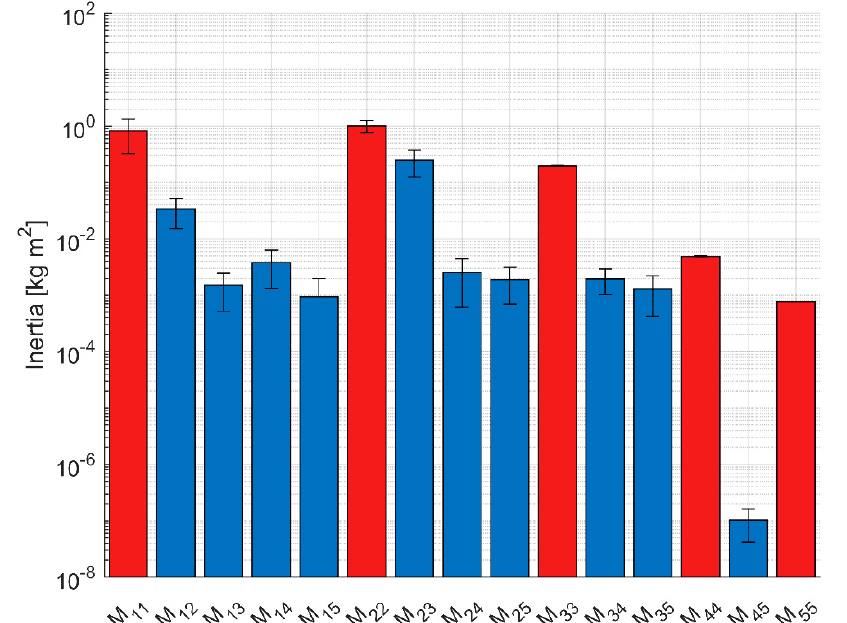
Figure 3. Mean values and standard deviations of mass matrix terms (10 6 random configurations), direct inertia terms (red bars) and inertial cross-coupling terms (blue bars).